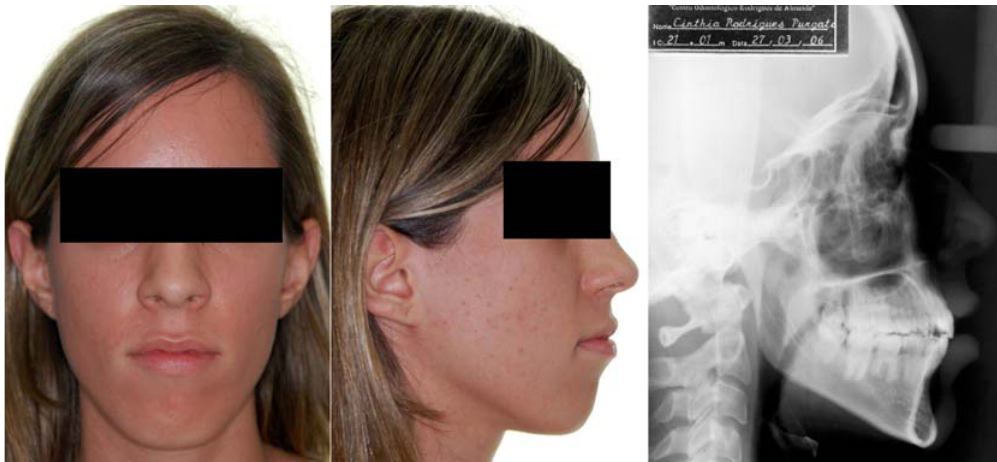
FIGURE 7- Frontal and lateral facial views and cephalometric lateral radiograph 8 years after treatment